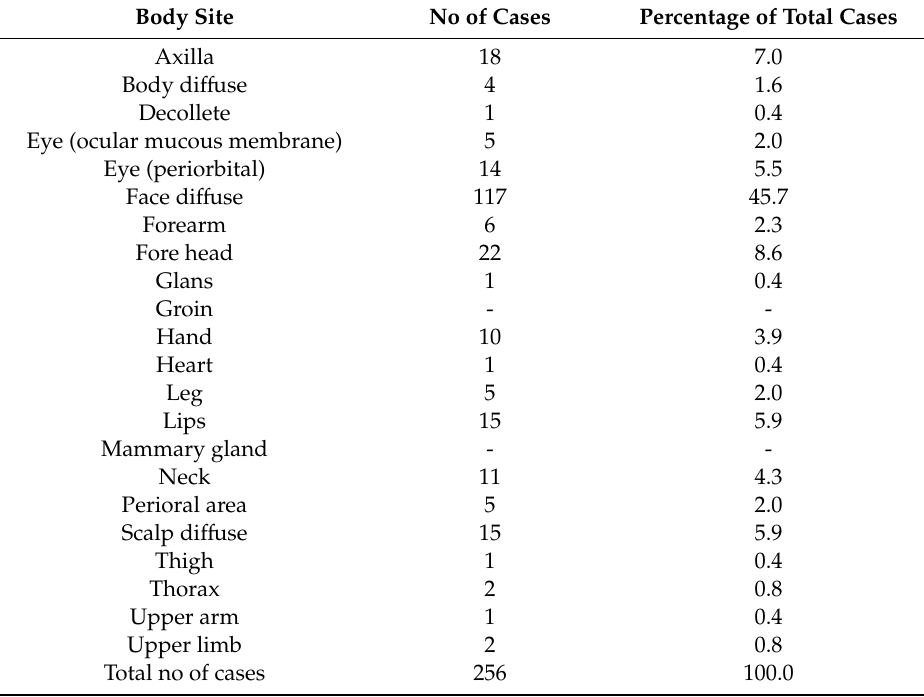
Table 4. A ff ected body